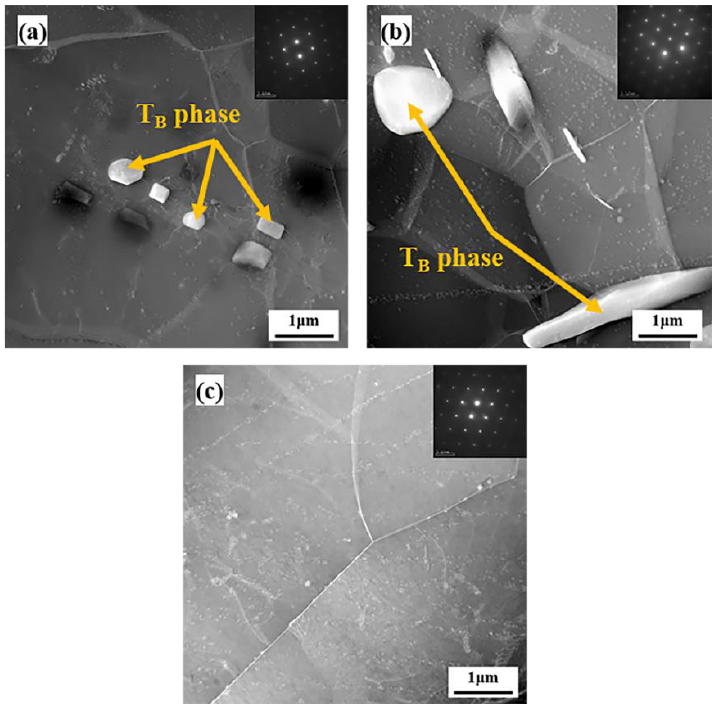
Figure 10. TEM images along <110> Al zone axis of the samples at dissimilar temperatures: ( a ) 400 °C; ( b ) 450 °C; ( c ) 500